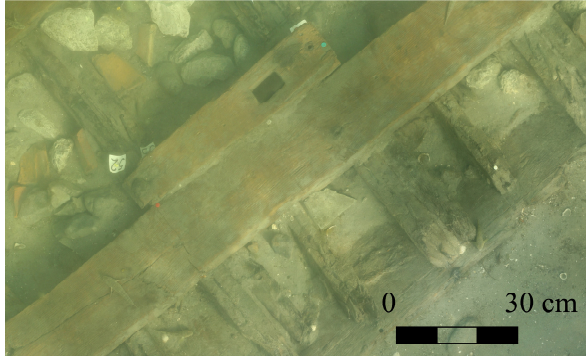
Figure 6. Orthophoto mosaic of the Phanagorian ship. A